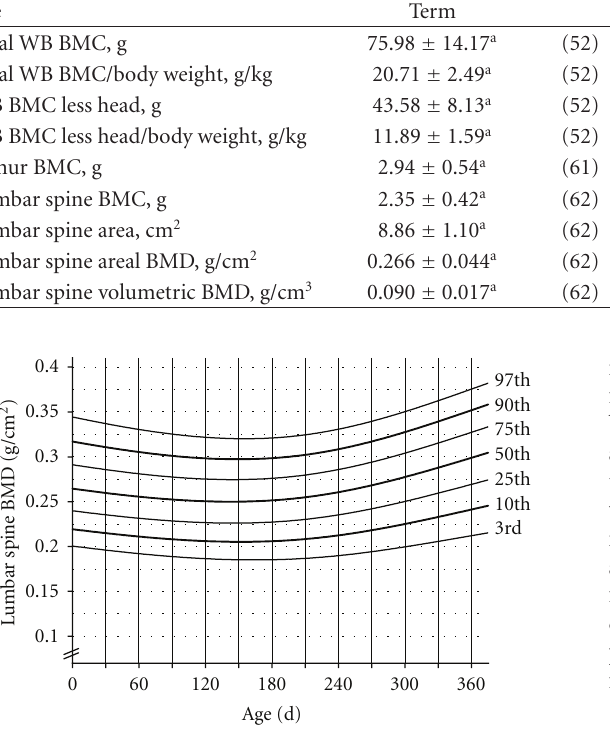
Figure 1: Spine BMD-for-age reference curve for infants, birth to